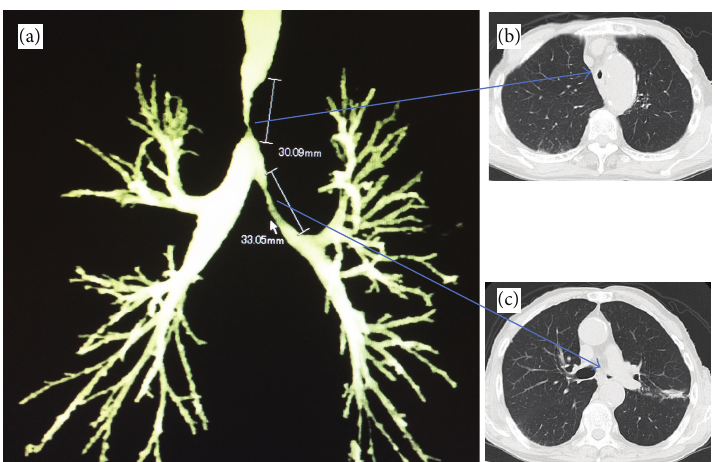
Figure 1: (a) Three-dimensional chest computed tomography (CT) showing stenoses of distal trachea and left main bronchus. (b) Stenosis of distal trachea. (c) Stenosis of left main